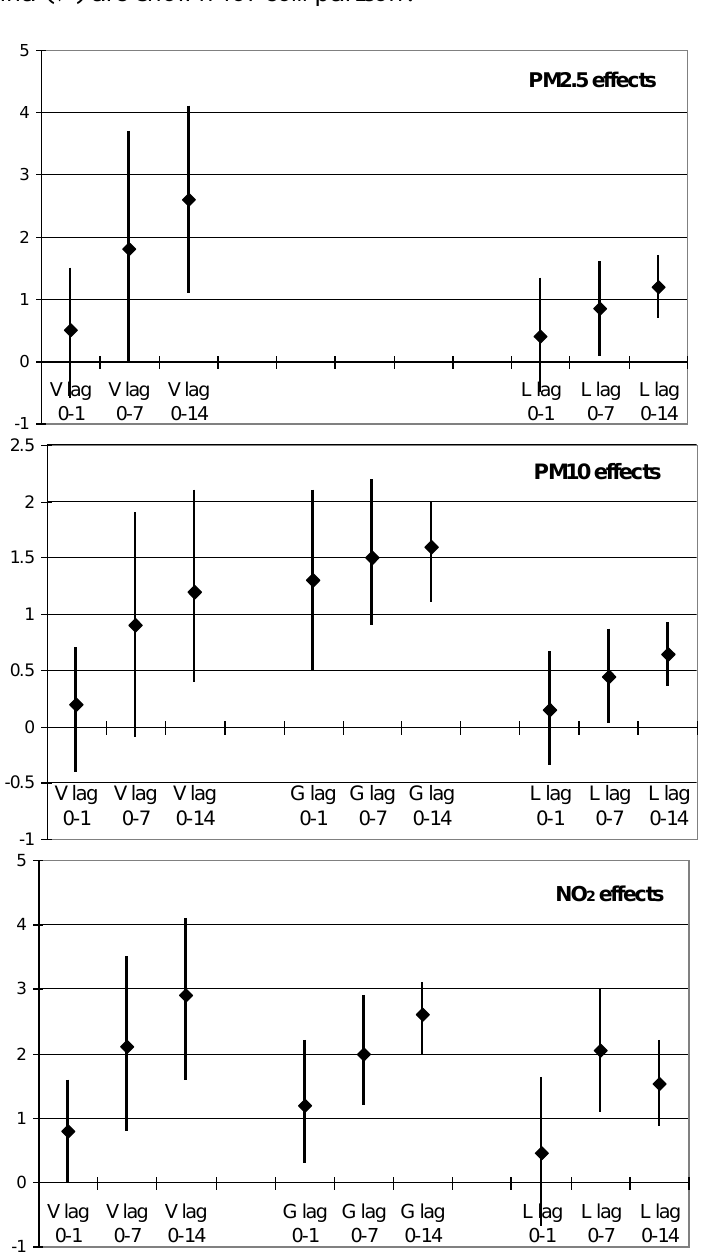
Figure 1. Per cent change in daily mortality, with 95% confidence intervals, in Graz (G) 1990–2005 and Linz (L) 1990–2007 per 10 µg/m³ increase in the respective pollutant measure over the preceding 2, 8, and 15 days (lag 0–1, lag 0–7, lag 0–14). Corresponding data [11] of Vienna (V) are shown for